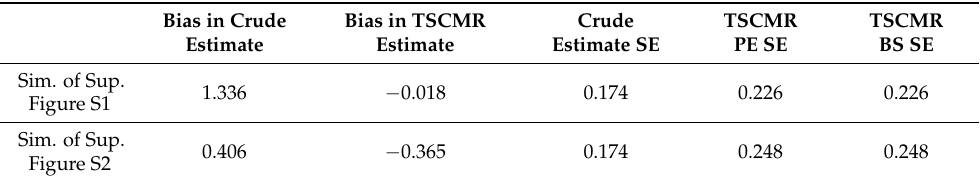
Table 2. Results of simulation to explore the ability of 2SCMR to simultaneously adjust for multiple biasing